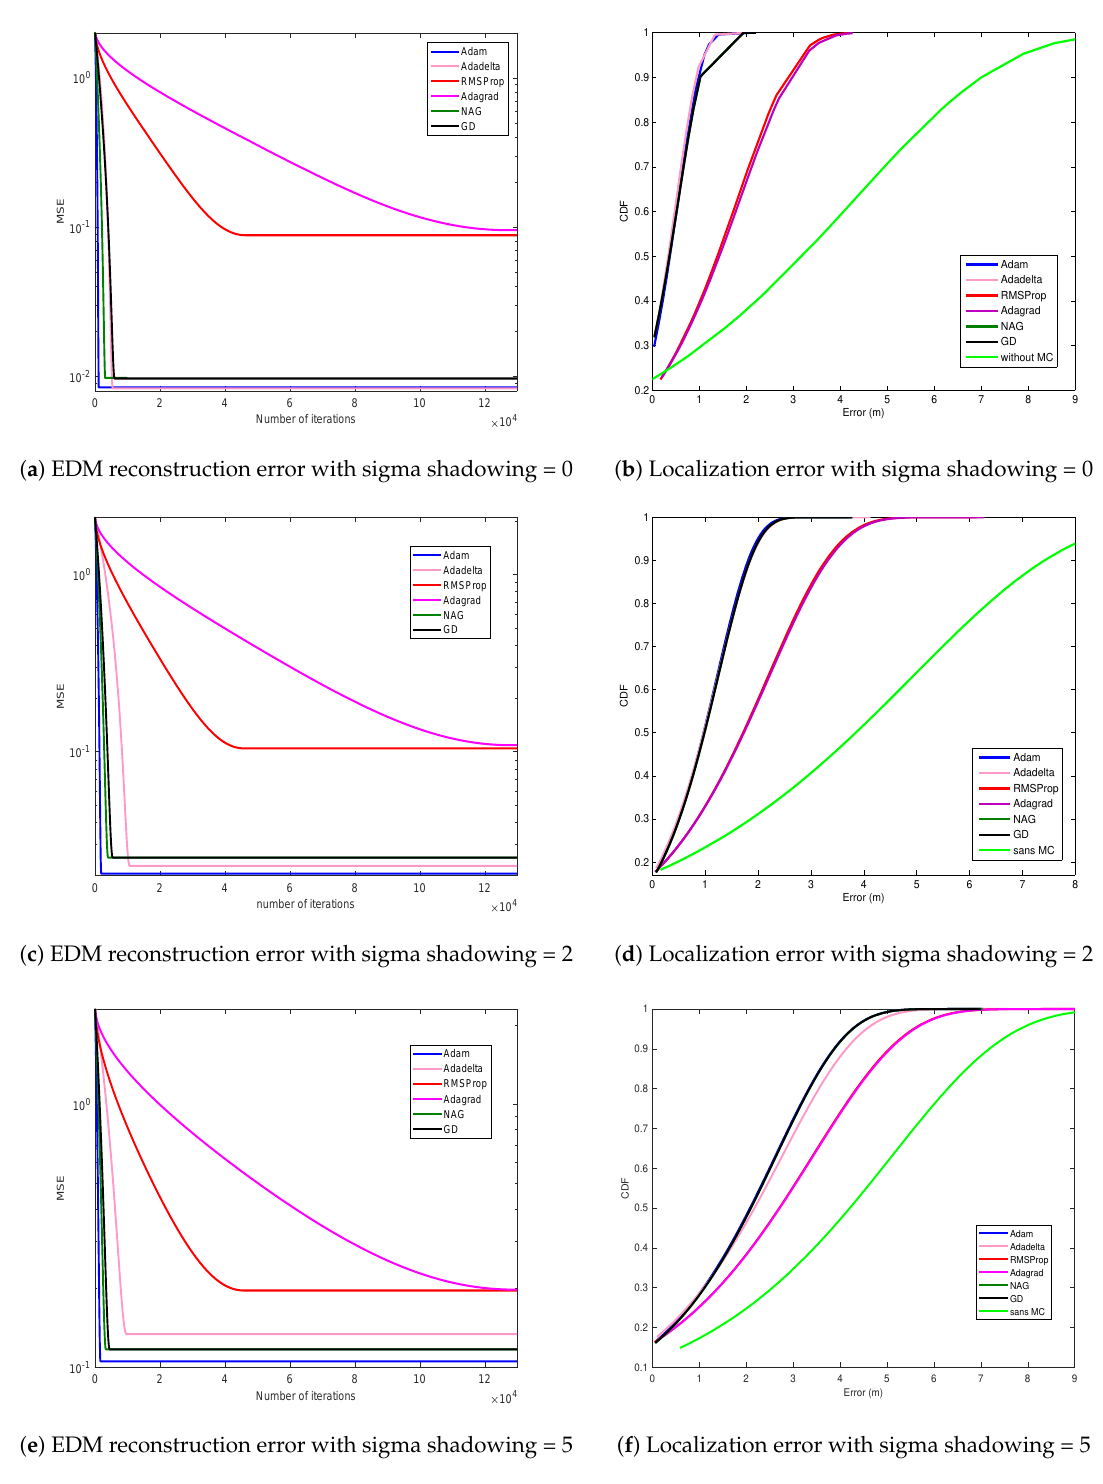
( f ) Localization error with sigma shadowing = 5 Figure 6. Algorithms’ performances (EDM: Euclidean distance